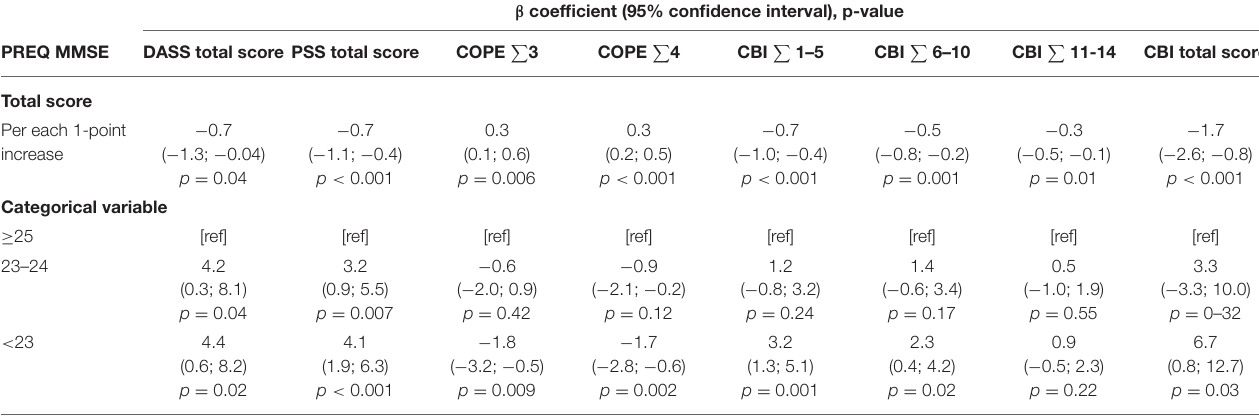
TABLE 3 | Linear regression models on the association between pre-quarantine MMSE and patients’ psychological well-being and caregivers’ burden during quarantine. β coefficient (95% confidence interval), p-value PREQ MMSE DASS total score PSS total